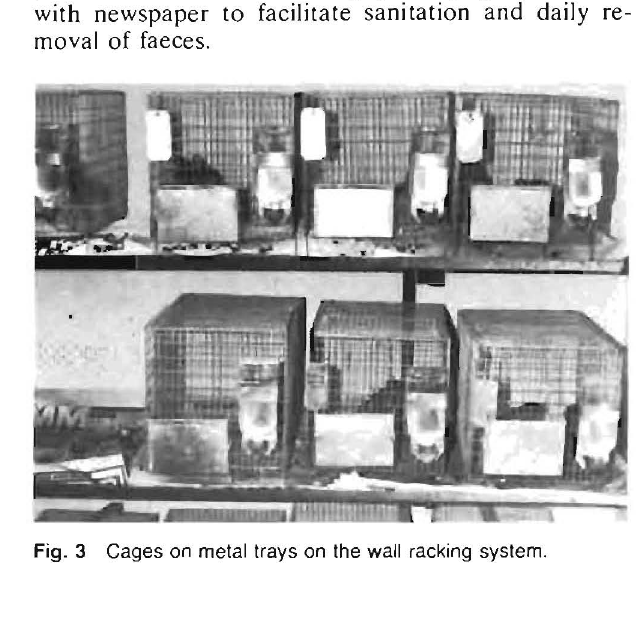
Fig. 2 Standard weldmesh cage used for rearing and egg produc tion.